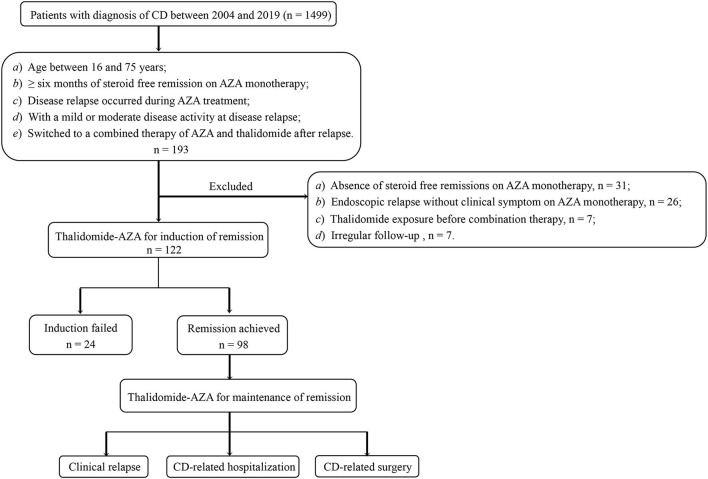
This is the flow of patients in the study. CD, Crohn's disease; AZA, azathioprine.